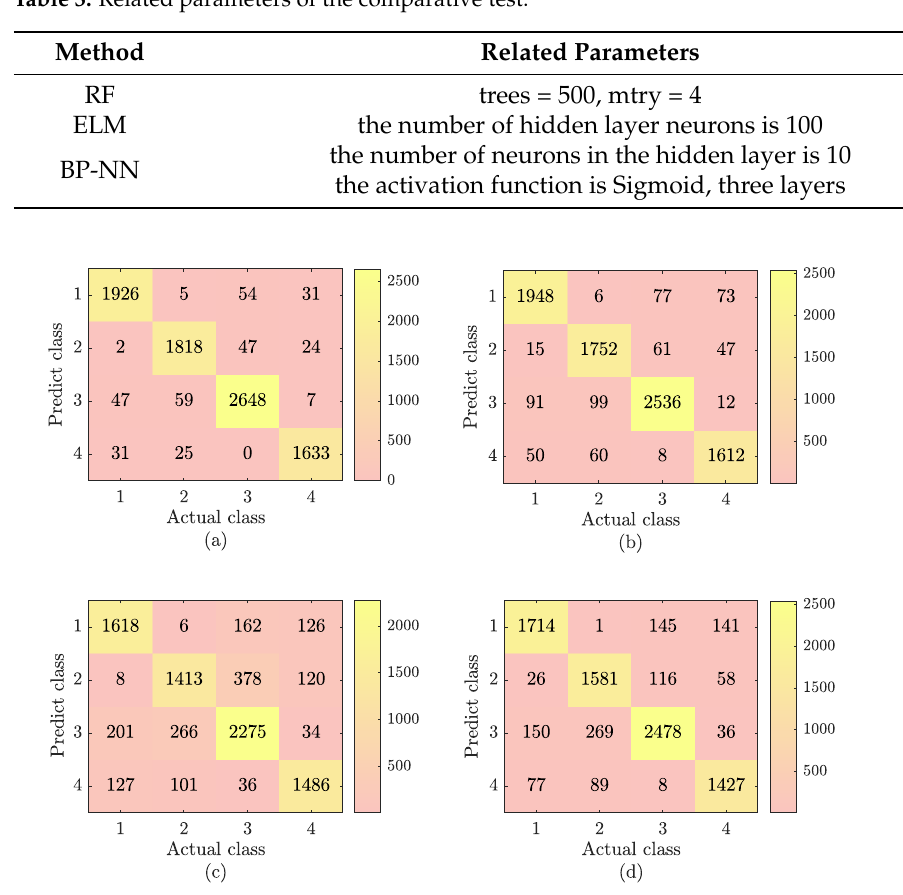
Figure 4. Mixed gas results for four mixed-gas-identification methods. ( a ) The SSA-SVM gas- identification results; ( b ) the RF gas-identification results; ( c ) the ELM gas-identification results; and ( d ) the BP neural network gas-identification